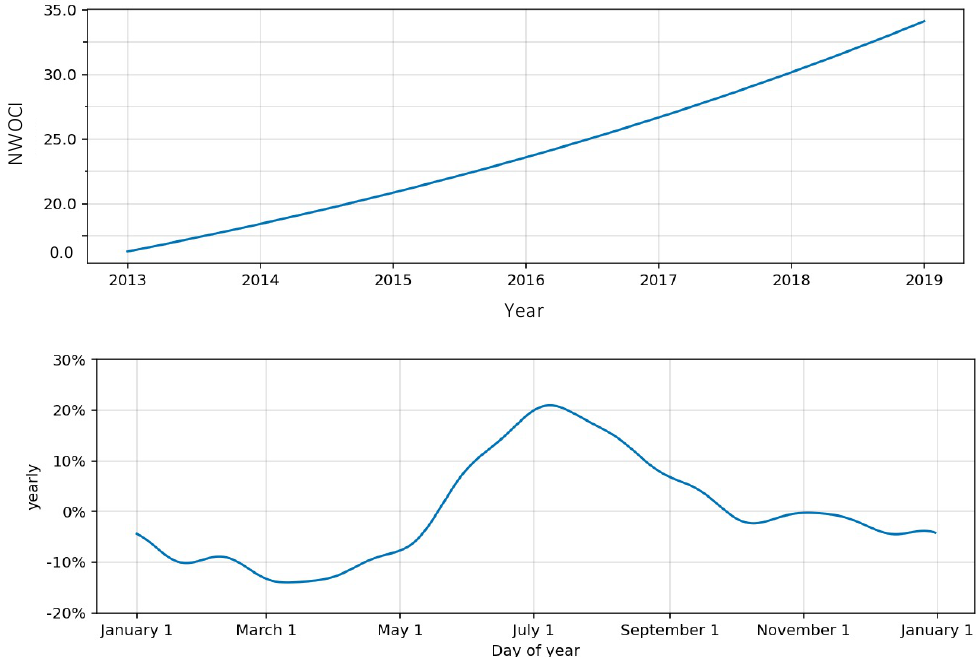
Figure 7. Top : Forecast components (trend and seasonality) with the Prophet-TPE model for the state of MA. N.B: The top panel shows the forecast trend of NWOCI based on the Prophet-TPE state level forecast. The bottom panel shows the decomposed yearly seasonal pattern of